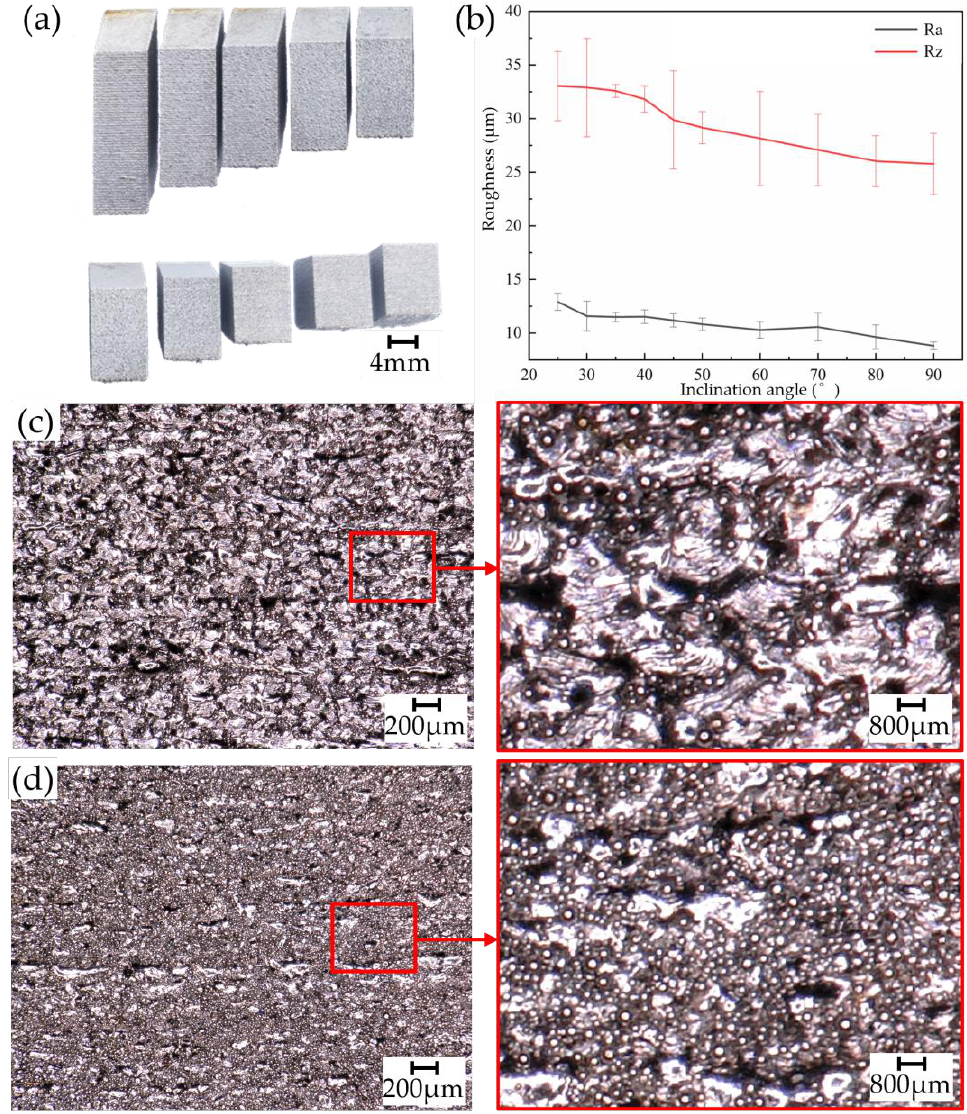
Figure 9. Upper side of parts with different inclination angles: ( a ) forming effect; ( b ) roughness curve; ( c ) 25° macroscopic morphology; ( d ) 90° macroscopic morphology.